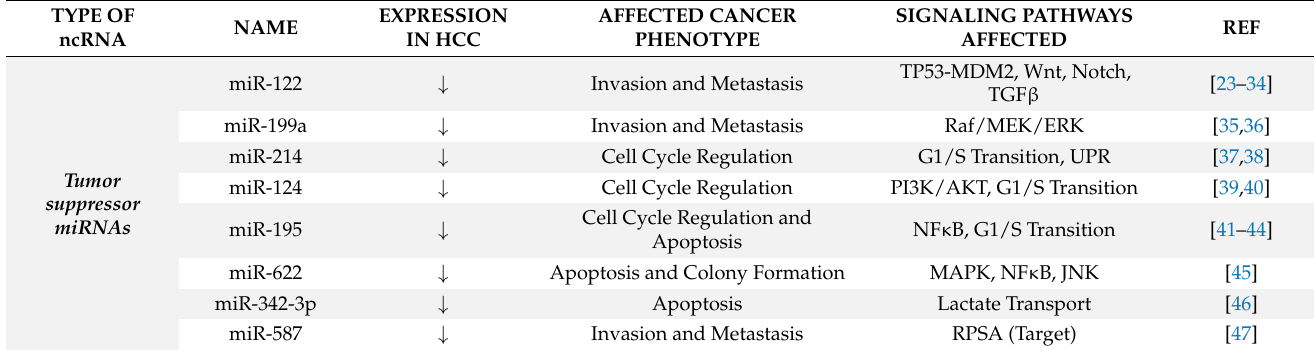
Table 1. Summary of key PDAC-related non-coding RNAs. Table listing all lncRNAs discussed